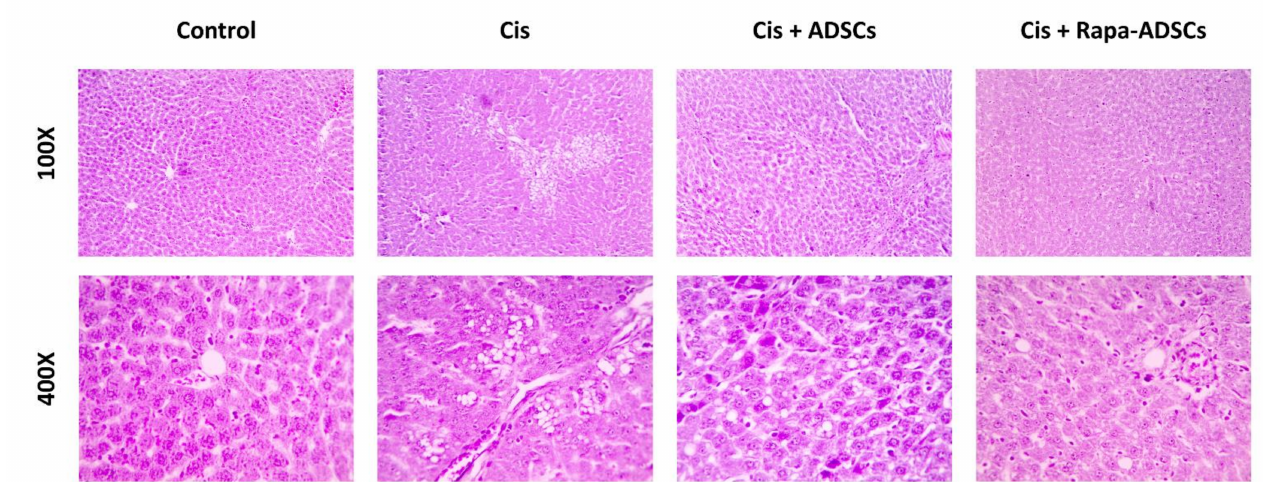
Figure 5. Photomicrographs showing the effect of administering rapamycin-preconditioned ADSCs on liver histopatho- logical picture in cisplatin (Cis)-induced liver damage. Cis, cisplatin (i.p. injection of 5 mg/kg in 0.9% saline) group, Cis + ADSCs, cisplatin group receiving ADSCs (one million cells, intravenous in tail vein) and Cis + Rapa-ADSCs, cisplatin group receiving same number of ADSCs preconditioned with rapamycin (50 nM/L, 2 h prior to administration). In the control group, normal liver histological picture was evident. In the cisplatin group, the liver showed marked degenerative and inflammatory changes, including distorted shape of hepatic lobules, inflammatory cells infiltration, necrotic hepatocytes and extensive vacuolations. In the cisplatin group that received ADSCs, the histopathological picture was improved with partially restored hepatic architecture and few degenerative lesions and vacuolations. Finally, in the cisplatin group receiving rapamycin preconditioned ADSCs, the best histological improvements were achieved in the liver compared to other groups, with near normal hepatic microscopic